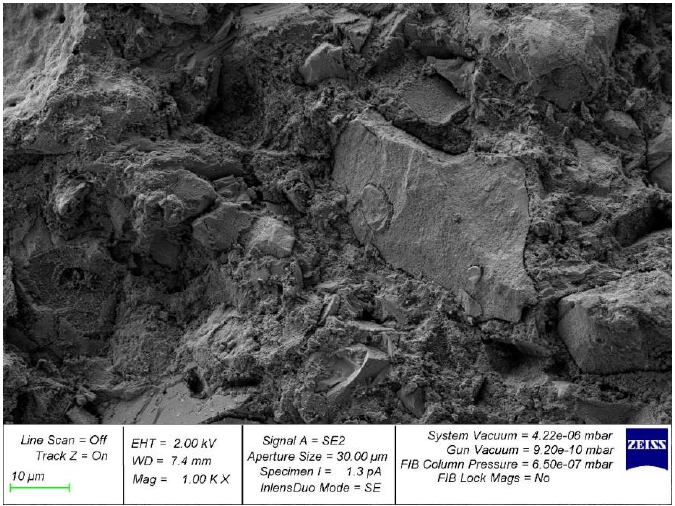
Figure 11. Sample with partial replacement of cement with eggshell powder at 15%.